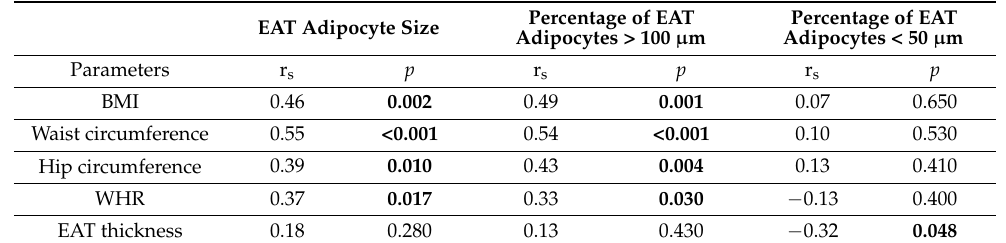
Table 4. Correlations of EAT adipocyte size, percentages of large and small adipocytes with an ‐ thropometric parameters of obesity and EAT thickness .